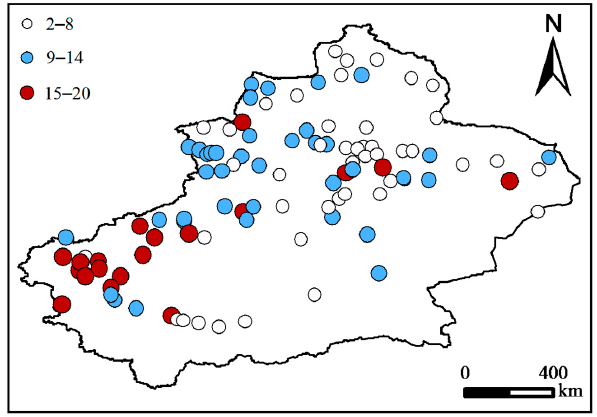
Figure 10. The spatial distribution of main periods in monthly snow depth in Xinjiang over 1961– 2015: ( a ) October, ( b ) November, ( c ) December, ( d ) January, ( e ) February and ( f ) March. The spatial distribution of main periods of the annual snow depth in Xinjiang is mapped in Figure 11. The short and medium periods were mainly distributed in north Xinjiang, and the long period was mainly distributed in southwestern Xinjiang.